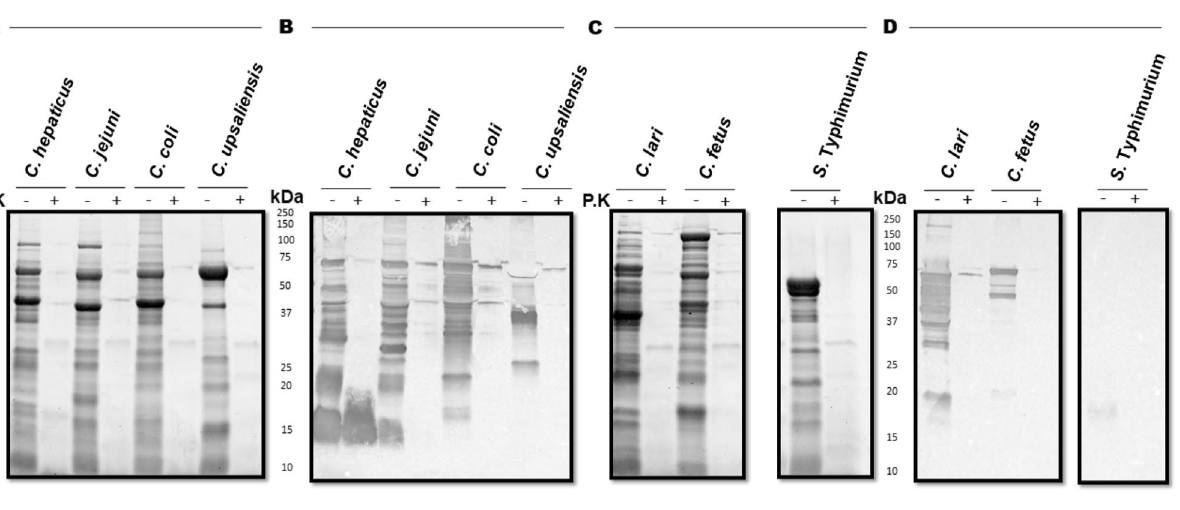
Figure 2. ( A ) SDS-PAGE of C. hepaticus HV10 T , C. jejuni 354, C. coli 52/2 and C. upsaliensis 54/7 whole cell lysates (WCL) containing 25 µg of protein. ( B ) SBA lectin blot binding profiles to N- glycans present in WCL of C. hepaticus HV10 T , C. jejuni 354, C. coli 52/2, C. upsaliensis 54/7 containing 25 µg of protein. ( C ) SDS-PAGE of C. lari 54/6, C. fetus 54/3 alongside negative controls, S. Typhimurium PT44. The equivalent amount of protein from WCL of the different Campylobacter species were also digested with proteinase K (P.K).Whole cell lysates were separated by 8–16% SDS-PAGE and either developed with SimplyBlue™ SafeStain or transferred to PVDF membranes for blotting. ( D ) SBA lectin blot binding profiles to N-glycans present in WCL of C. lari 54/6, C. fetus 54/3, C. coli 52/2, E. coli JM109 and S. Typhimurium PT44 containing 25 µg of